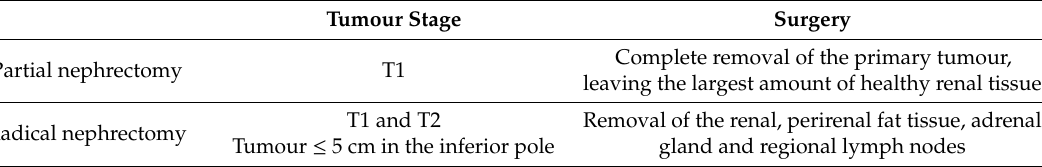
Table 2. Surgical treatment for renal cell carcinoma [9].